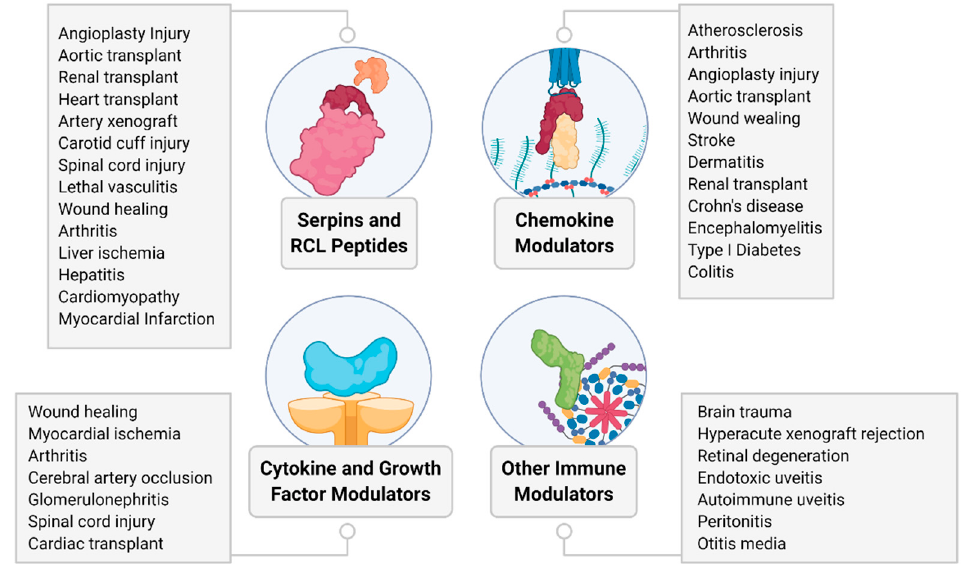
Figure 5. Summary overview of diseases and conditions tested for therapeutic efficacy of virus-derived proteins in preclinical models discussed in this review.